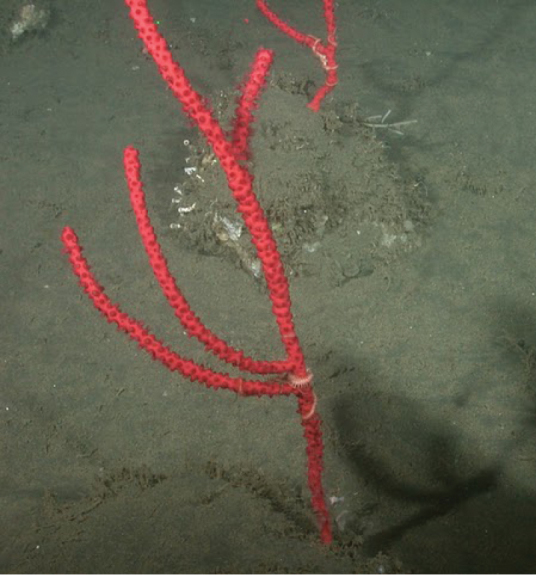
In situ image of what appears to be Chromoplexauramarki, DSCN5297. Colony seen off Oregon coast. Without initial examination of sclerites, originally thought to be Swiftiasimplex; examination of sclerites aligned it with C.marki. There can be remarkable similarity in external gross appearance between the two species. Image courtesy of Peter Etnoyer, NOAA, 2010.